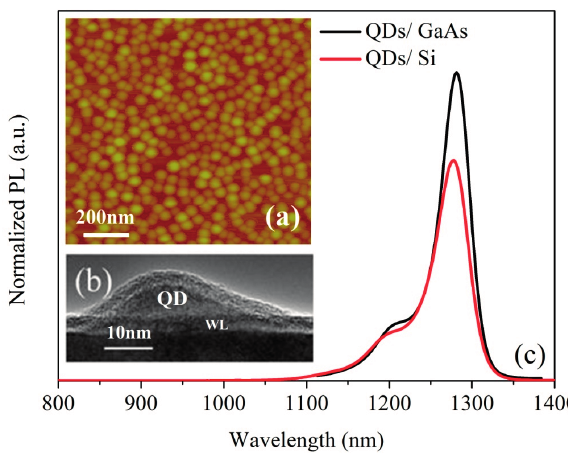
Figure 2. ( a ) AFM image of InAs quantum dots (QDs) grown on Si substrates. ( b ) Cross-sectional TEM image of one InAs QD. ( c ) Normalized photoluminescent (PL) room temperature (RT) emission spectra of InAs/GaAs QDs grown on Si substrate and GaAs substrate with the same growth